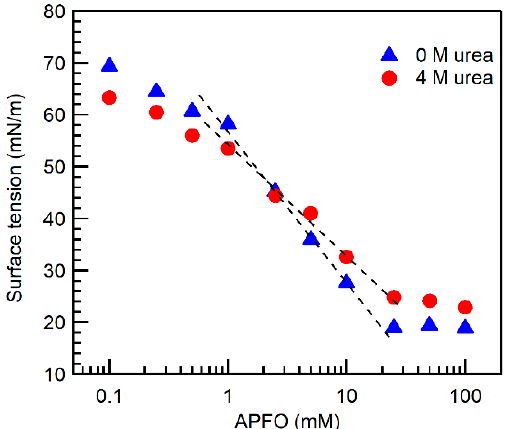
Figure 2. Surface tension of APFO aqueous solutions in the absence and in the presence of 4 M urea (24 °C). Linear fits have been applied to the data points where the surface tension decreases prior to reaching the CMC.